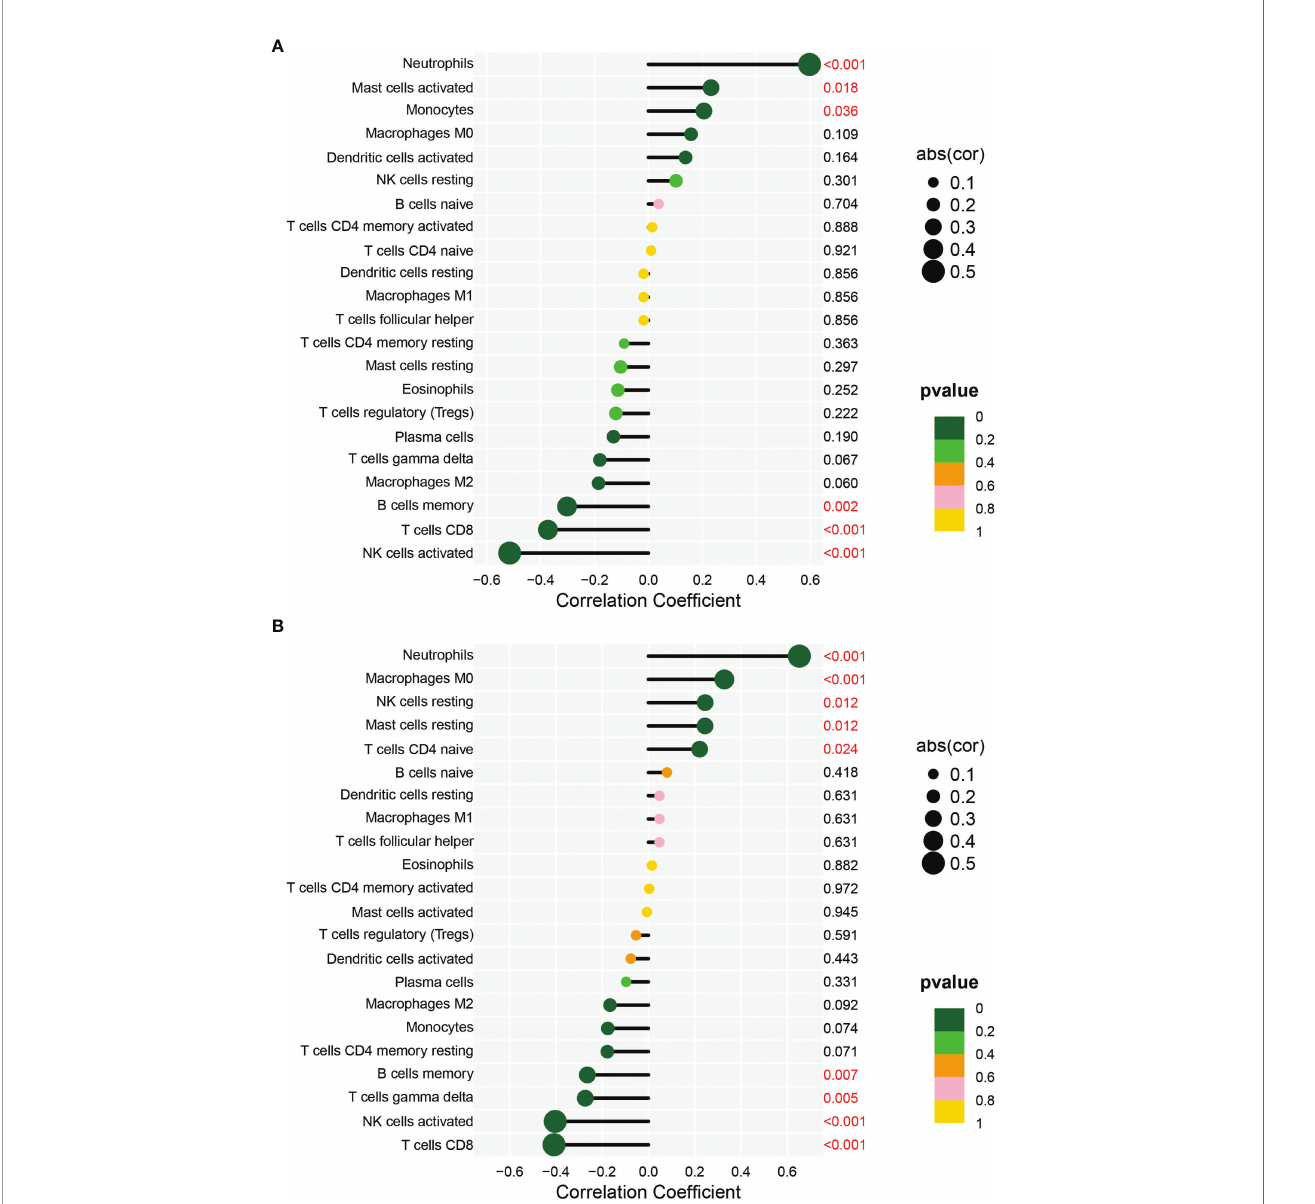
FIGURE 8 | Immune correlation lollipop plot. (A) shows the immune cells with signi fi cant difference of ANXA3 in AS and control. (B) shows the immune cells with signi fi cant difference of SORL1 in AS and